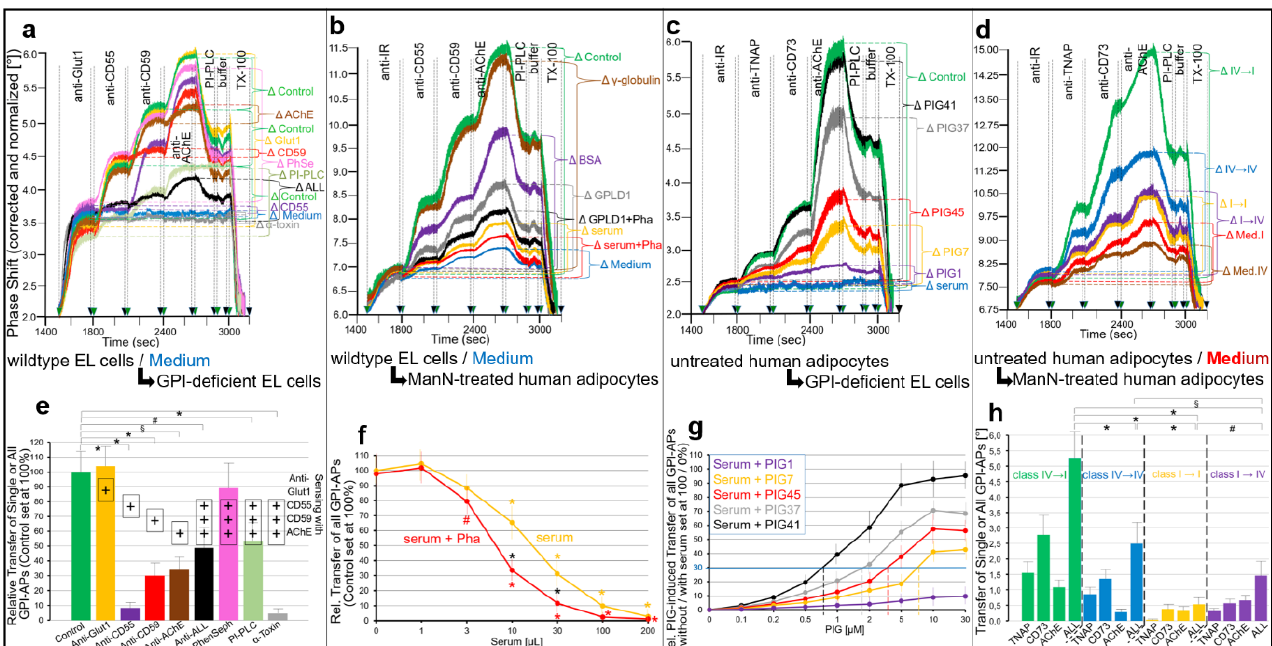
Figure 9. Biochemical and cell biological characterization of the intercellular transfer of GPI ‐ APs. Transwell co ‐ cultures were run with ( a , e ) wildtype and GPI ‐ deficient EL cells, ( b , f ) wildtype EL cells and ManN ‐ treated human adipocytes of lipid ‐ loading stage II (see Supplementary Materials, Figure S6), ( c , g ) untreated human adipocytes of lipid ‐ loading stage II and GPI ‐ deficient EL cells, or ( d , h ) untreated and ManN ‐ treated human adipocytes of the indicated stage of lipid ‐ loading (class donor → class acceptor adipocytes) in the insert and bottom wells, respectively, as described in the legend to Figure 8. Where indicated, only medium was present in the insert wells ( a , b , Δ Medium; d , Δ Med.I/IV for adipocytes of lipid ‐ loading stage class I and IV, respectively). After incubation (37 °C, 1 week, serum ‐ and albumin ‐ free medium) in the absence ( Δ Control) or presence ( a , e ) of single antibodies (source and titer used see Ref. [83] against Glut1, AChE, CD55 or CD59, or a combination of antibodies against all GPI ‐ APs (ALL), each coupled to protein A Sepharose, or phenylsepharose (150 μ L, PhSe/PhenSeph) or PI ‐ PLC ( Bacillus cereus , 0.2 U/mL) or α‐ toxin coupled to Sepharose (50 μ L), or ( b , f ) γ‐ globulin (15 mg/mL), or BSA (50 mg/mL), or GPLD1 (100 mU/mL), or GPLD1 with Pha (2 mM), or rat (obese ZDF) serum (100 μ L), or rat (obese ZDF) serum with Pha (2 mM) or ( c , g ) PIGs as indicated (10 μ M) or rat (obese ZDF) serum (100 μ L), PM were prepared from the cells of the bottom wells and then analyzed for the expression of GPI ‐ APs and transmembrane proteins by chip ‐ based SAW sensing as described for Figure 1. ( a – d ) Phase shifts induced by antibody binding and PI ‐ PLC ‐ or TX ‐ 100 ‐ treatment (from 1500 to 3100 sec) after correction and normalization are shown, only, with those induced by all antibodies against GPI ‐ APs (summation signals between 1800 and 2700 sec) are indicated by horizontal hatched lines and brackets for each period. ( e – h ) The experiments were repeated three to five times for the indicated configurations and agents ( e ), serum volumes ( f ) and concentrations of PIGs ( g ). ( e , f ) Phase shift Δ for each incubation of acceptor with donor cells was corrected for that with medium alone in the insert wells ( Δ Medium) and then used for calculation of the relative transfer of single or all GPI ‐ APs as monitored by chip ‐ based sensing with the indicated single or combined antibodies, respectively, with controls (no added agent or serum) set at 100%. Significant differences vs. control ( e ) or absence of serum ( f , orange and red symbols) as well as for serum vs. serum + Pha ( f , black symbols) are indicated. ( g ) Phase shift Δ were used for calculation of the relative PIG ‐ induced transfer of all GPI ‐ APs with absence and presence of serum set at 100 and 0%, respectively. ( h ) Phase shift Δ were corrected for those with medium alone in the insert wells ( Δ Med.I/IV, Δ Medium for lipid ‐ loading stage I or IV) for all configurations of stages of class donor → class acceptor adipocytes and used for calculation of transfer of single or all GPI ‐ APs [°]. Significant differences between the transfer of all GPI ‐ APs (ALL) are indicated (* p < 0.01, # p < 0.02, § p < 0.05).